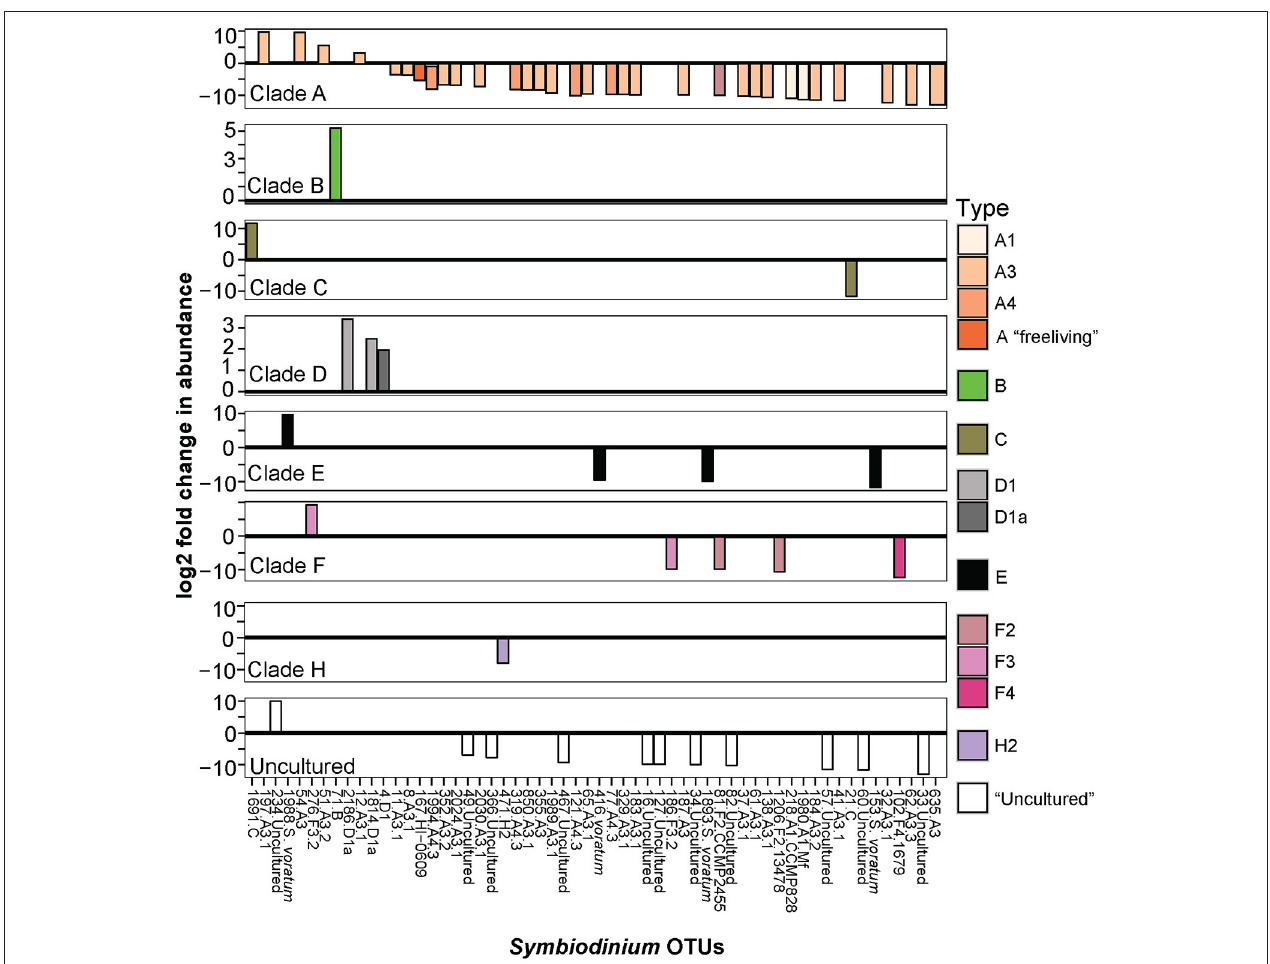
FIGURE 4 | Significant log2 fold changes in normalized abundances of Symbiodinium OTUs in inshore compared to offshore sediments. Positive values above the y = 0 line (in bold and black) denote Symbiodinium OTUs found in significantly greater abundances in inshore sediments. Note different scales on the